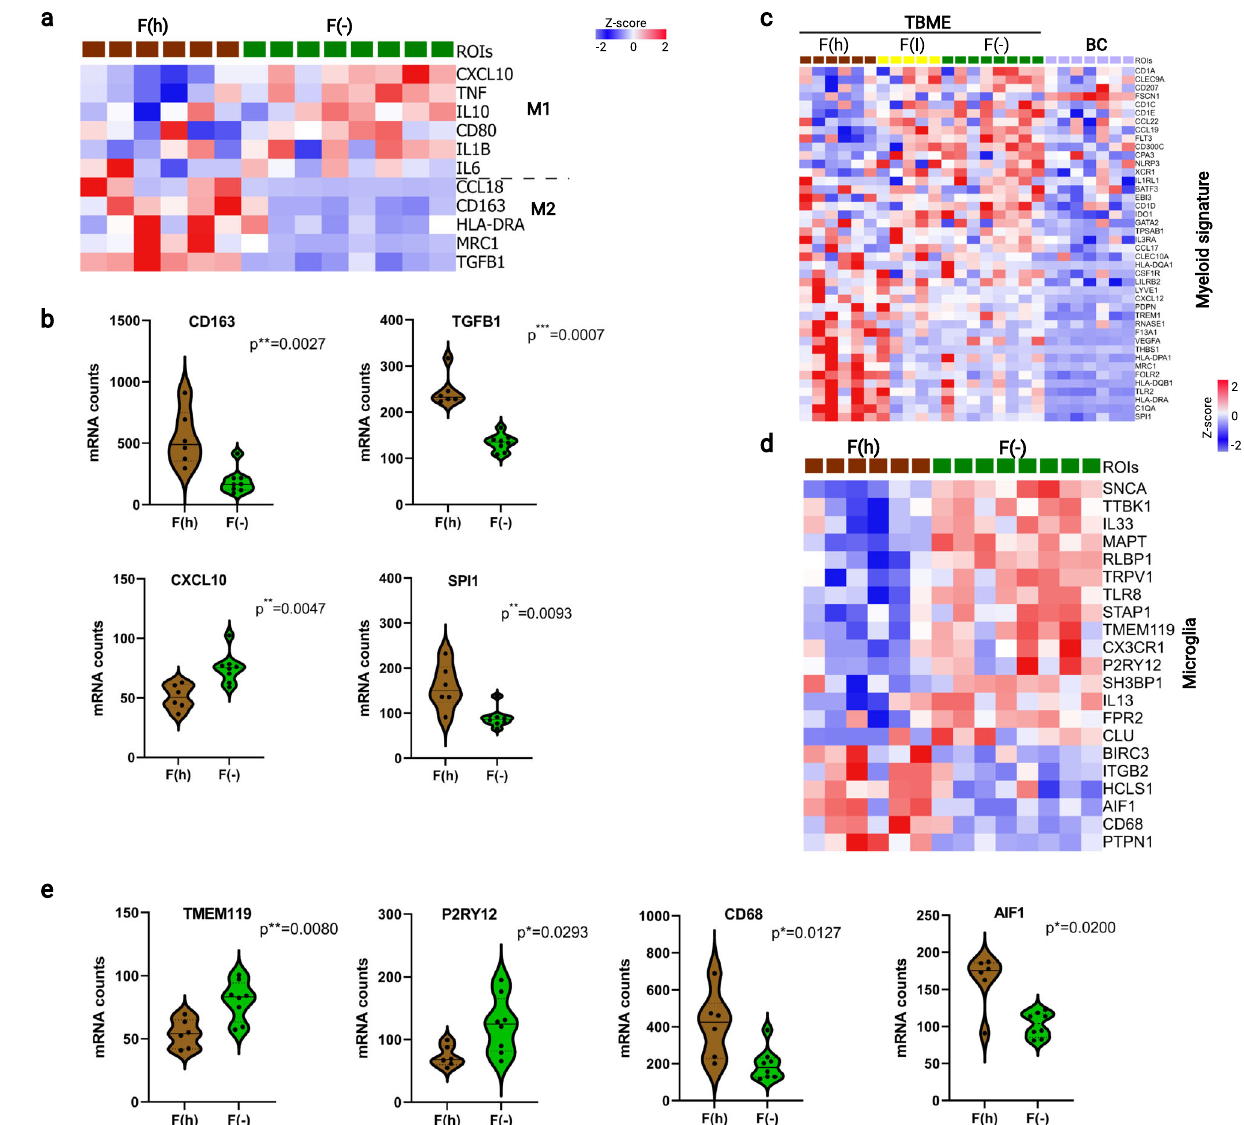
Fig. 5 | Microglia – macrophage reprogramming in the TBME. a Heatmap of dif- ferentialexpressionofspeci fi cgenesfortheM1andM2macrophagesintheF(h)vs. F( − ) TBME. b Violin plots showing the signi fi cant differences in expression of CD163, TGFB1, CXCL10, and SPI1 between the F(h) vs. F( − ) TBME. The dashed and solid lines within the plots indicate upper and lower quartiles and medians, respectively. c Heatmap of differentially expressed myeloid signature gene in the TBMEandBCROIs, n =8,6,5,and7samplesinF( − ),F(h),F(I),andBC,respectively.